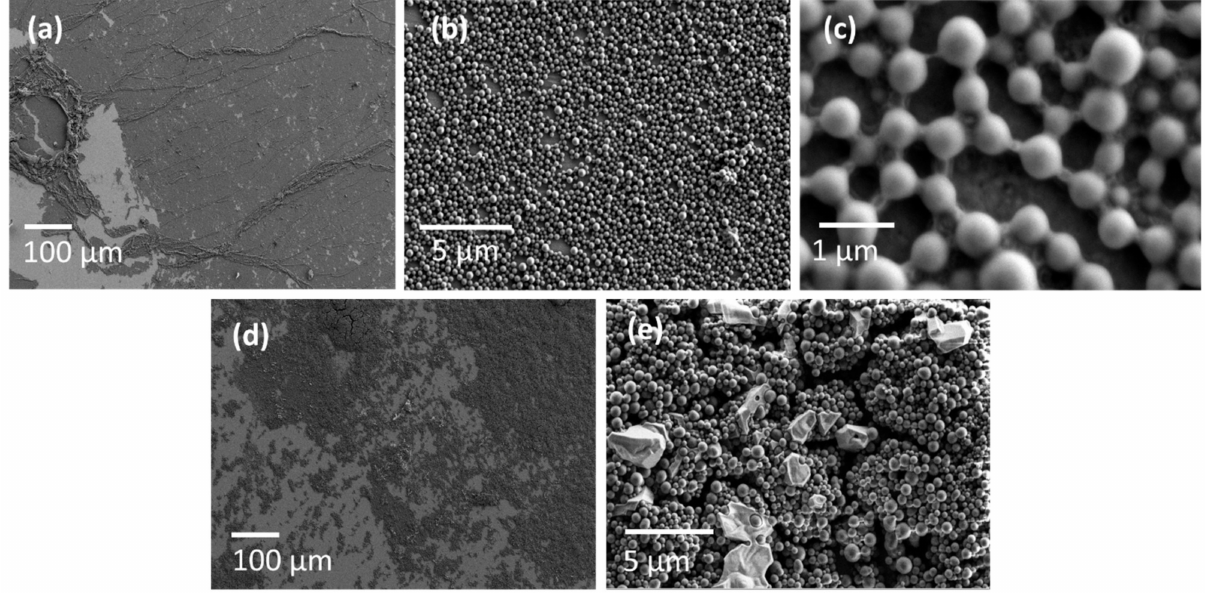
Figure 8. SEM images at different magnifications, ( a , d ) × 300, ( b , e ) × 10,000, ( c ) × 80,000, of LYS microgel layers, which were spread with the addition of ethanol, at the surface of a phosphate buffer at pH 7 ( a – c ) and without the addition of ethanol at the surface of 0.1 M NaCl solution at pH 10 ( d , e